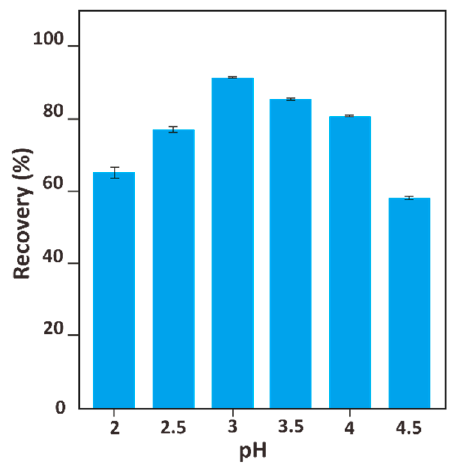
Figure 11. Monosodium glutamate (MSG) recovery e ffi ciency as function of pH.